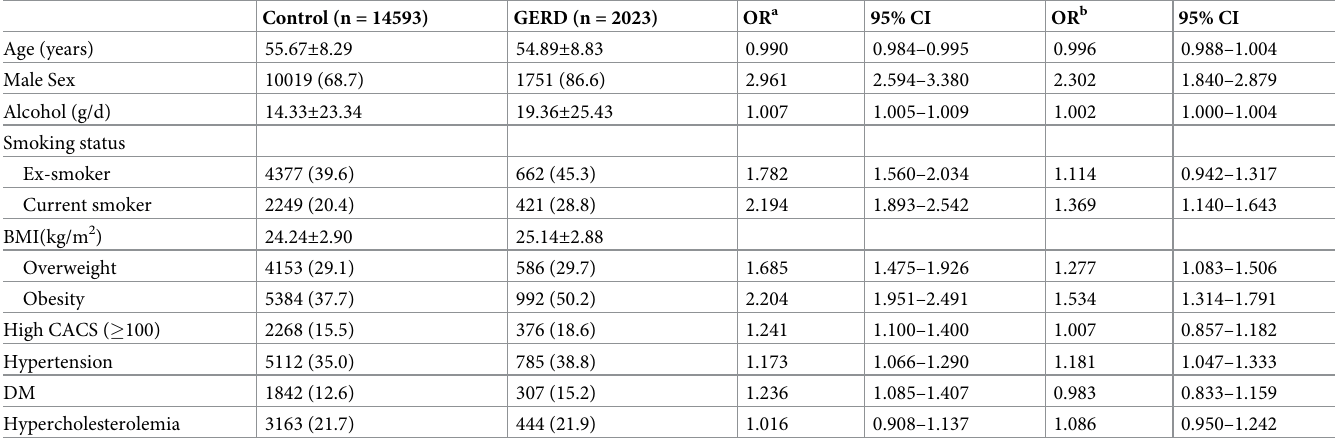
Table 1. Risk factors for GERD.